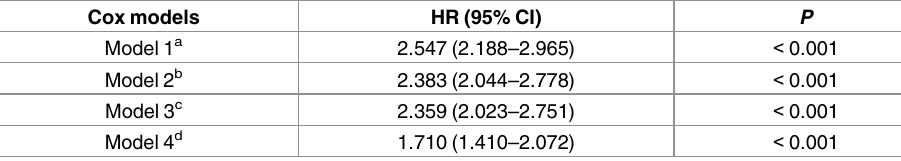
disease, cancer, bacteremia, body mass index, systolic blood pressure, serum albumin, white blood cells, hemoglobin, sodium, potassium, total cholesterol, total bilirubin, serum creatinine, aspartate aminotransferase, and alanine